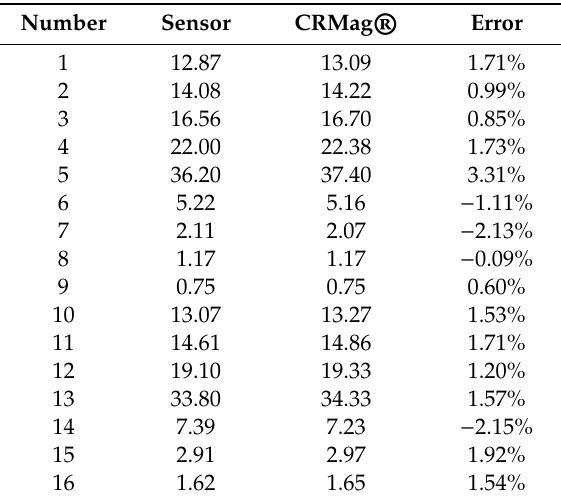
Figure 3. Simulation of the test circuit. Table 1. Comparison of simulation and measurement results.